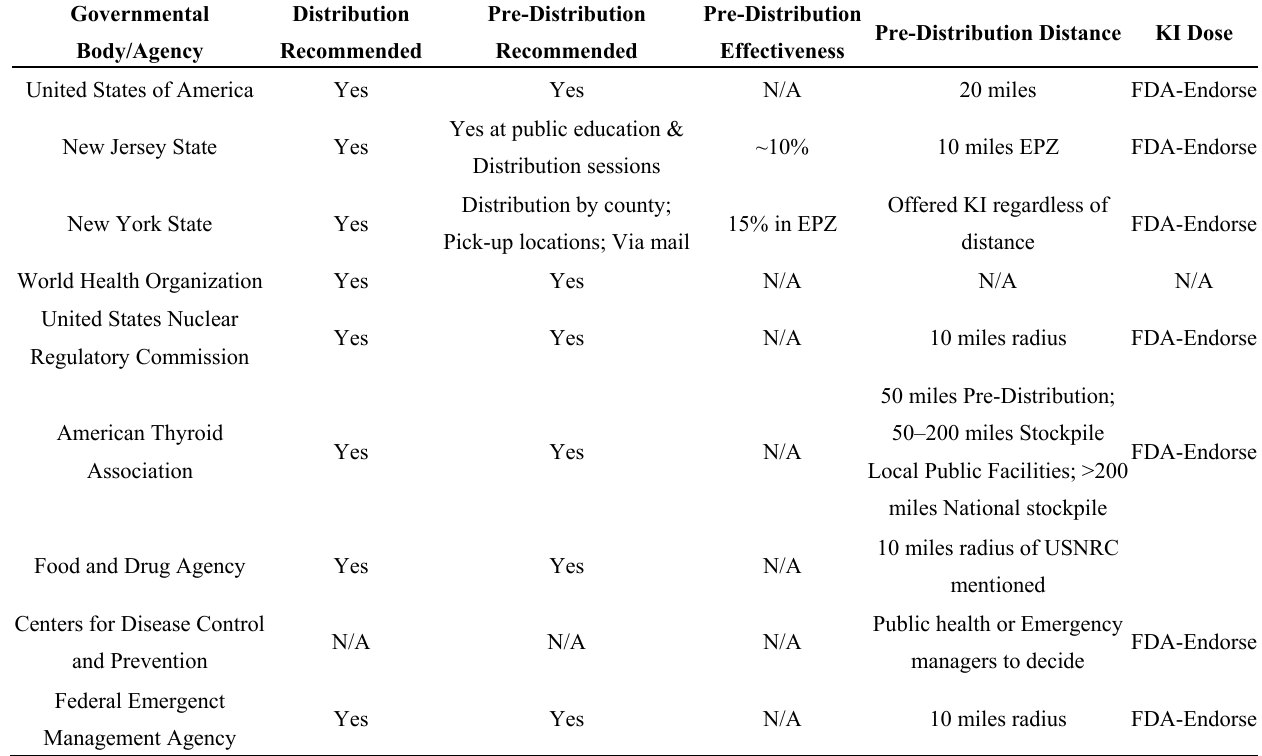
Table 5. Governmental body/agency, KI usage and emergency preparedness